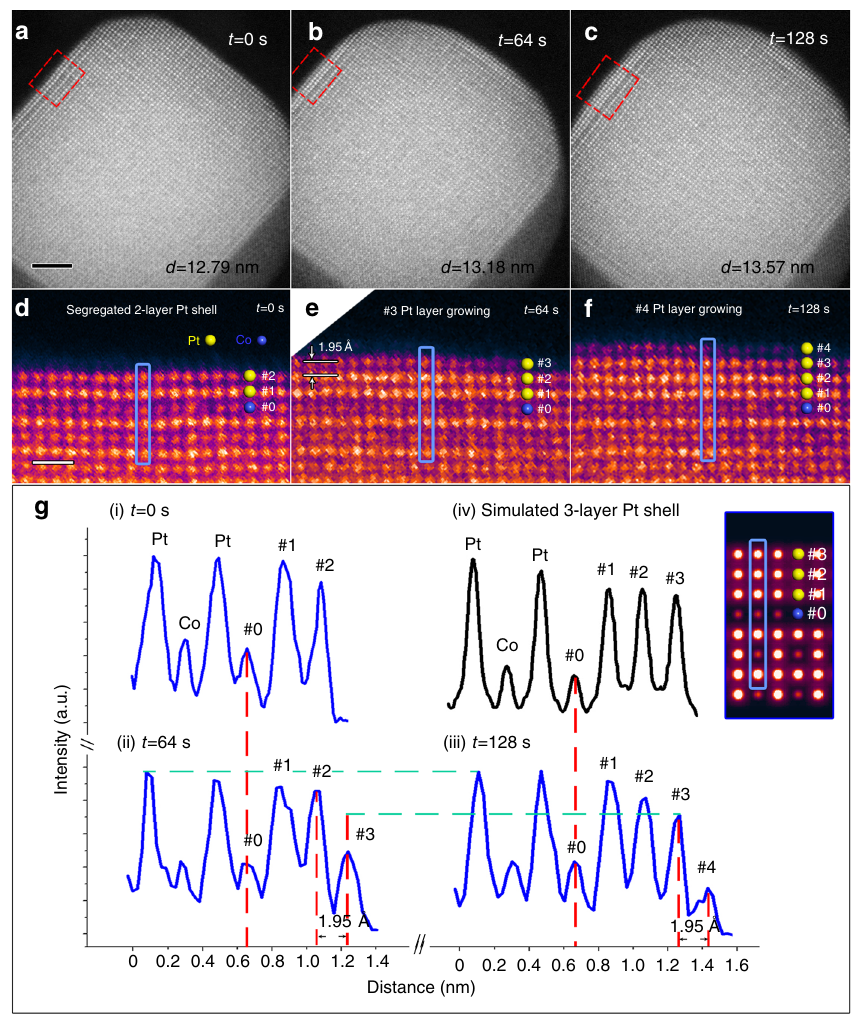
Fig. 3 Layer-by-layer growth of the (100) Pt shell during oxygen annealing. a – c Sequential HAADF images taken at 0, 64, and 128 s during oxygen annealing at 300 °C, respectively. Scale bar, 2 nm. d – f Corresponding enlarged false-colour panels of the (100) surface (indicated by red boxes) in a – c , respectively. Yellow and blue spheres represent Pt and Co atoms, respectively. Scale bar, 5 Å. g Intensity pro fi les taken along the blue lines in d – f , and the simulation result, respectively. The inset shows the simulated image of the three-layer Pt shell on the (100)